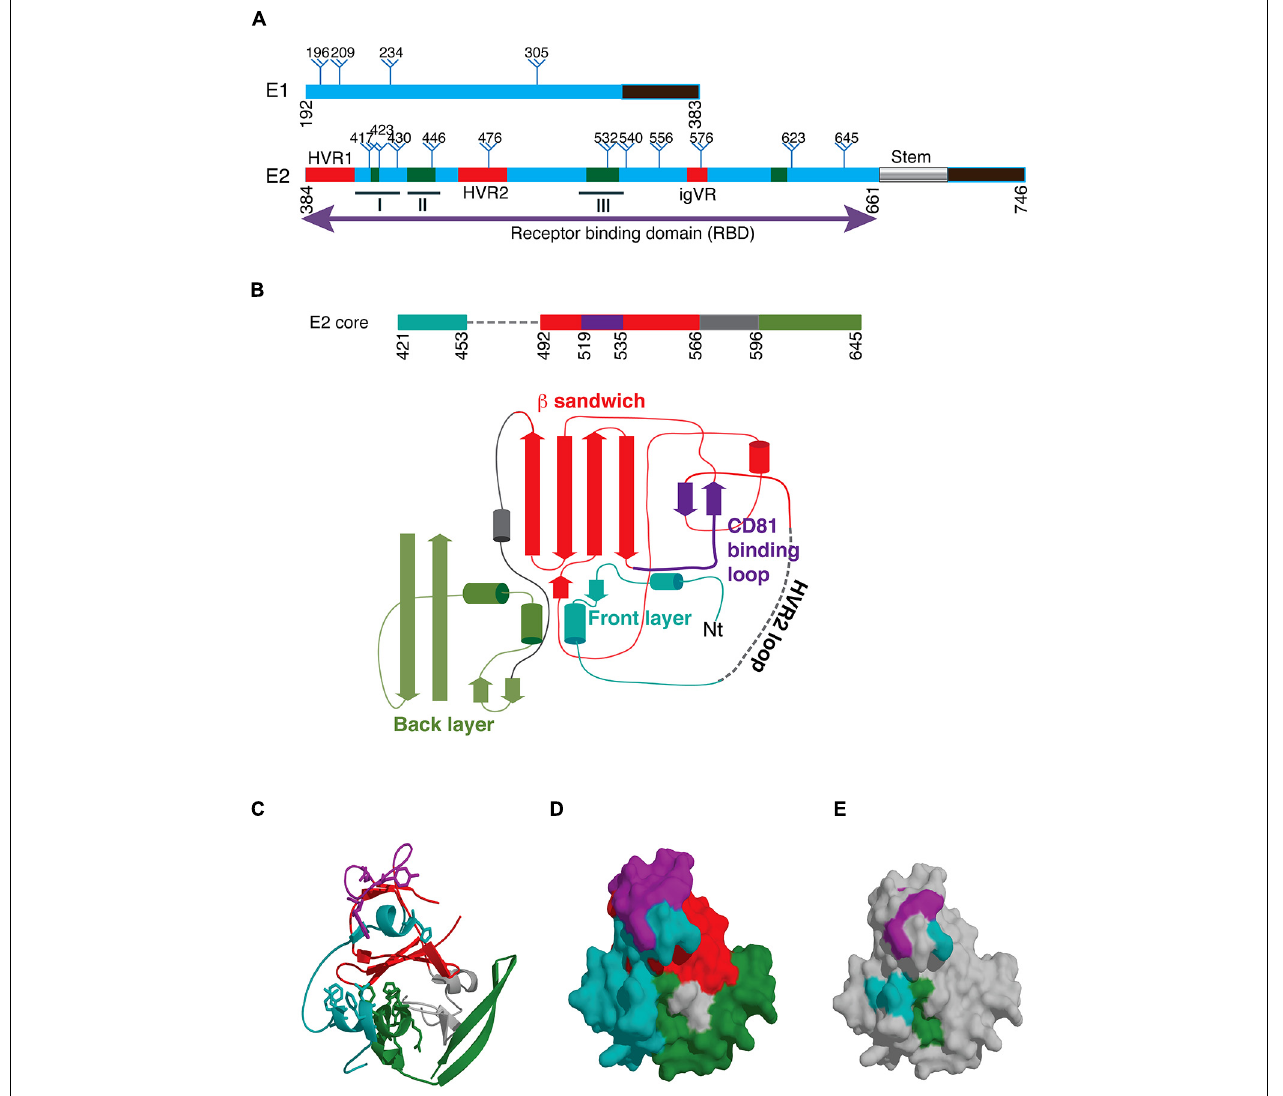
(B) Schematic of the E2 core domain according to the designations of Kong etal. (2013). (C) Structure of the E2 core domain colored according to B . (D) Surface representation of C . Purple and teal regions represent the neutralizing face of E2 and overlap with CD81 contact residues shown in E . (E) Surface representation of the E2 core domain with those residues involved in CD81 with their locations colored according to B